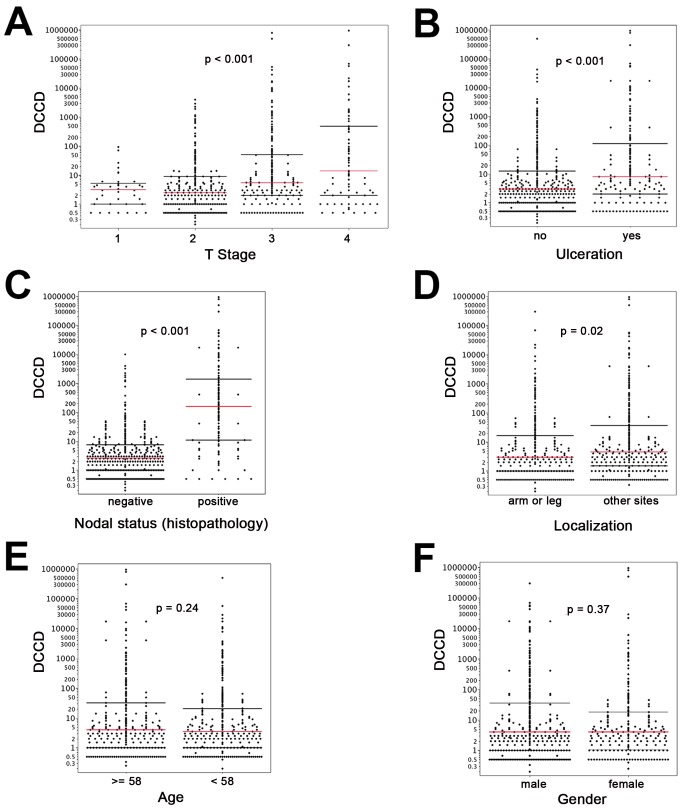
DCCD and standard clinical prognostic factors.For all panels, the red lines indicate the medians, and the black lines the 25th and 75th percentiles. (A) All DCCD values are plotted according to the T stage of the primary melanoma. (B) DCCD and ulceration state of the primary melanoma. (C) DCCD and status according histopathological routine analysis of the other lymph node half. (D) DCCD and localization of the primary melanoma. (E) DCCD and age category (<58 y and ≥58 y) of patient. (F) DCCD and gender of patient.